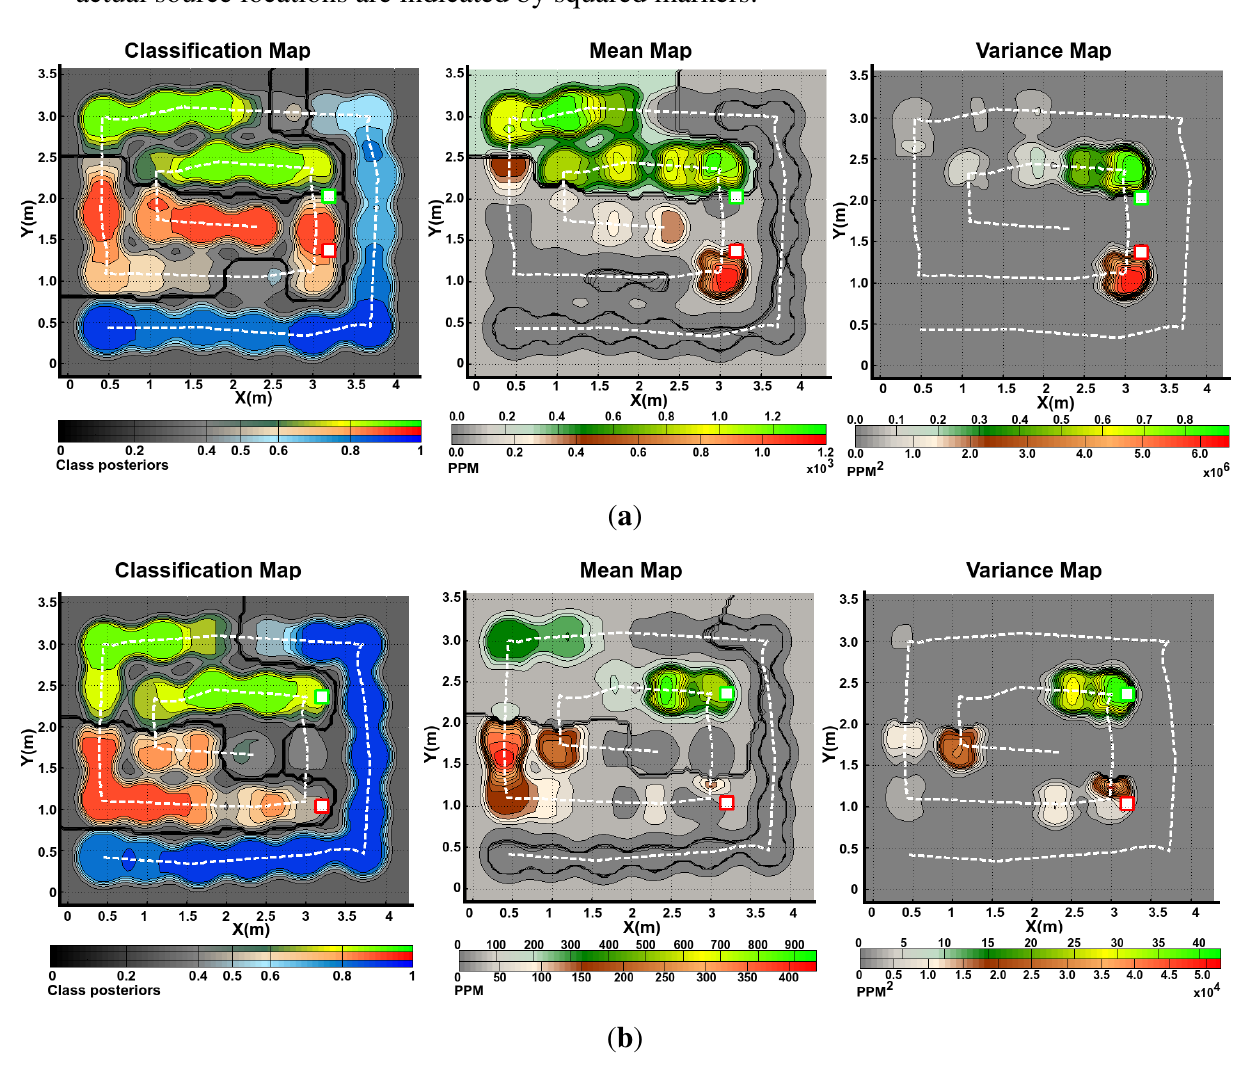
Figure 6. Generated gas distribution models of two experiments in the robot arena with Ethanol (green) and propanol (Red) gas sources separated by different distances ( a ) 0 . 5 m , ( b ) 1 . 5 m . The blue shades in the classification maps denote the likelihood of finding clean air at a given position in the explored area. The dashed lines denote the robot’s path and the actual source locations are indicated by squared